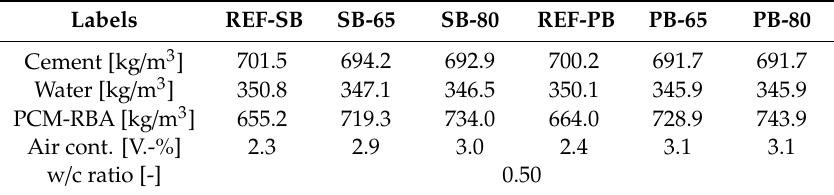
Table 1. Overview of the six PCM-RBA mortars.